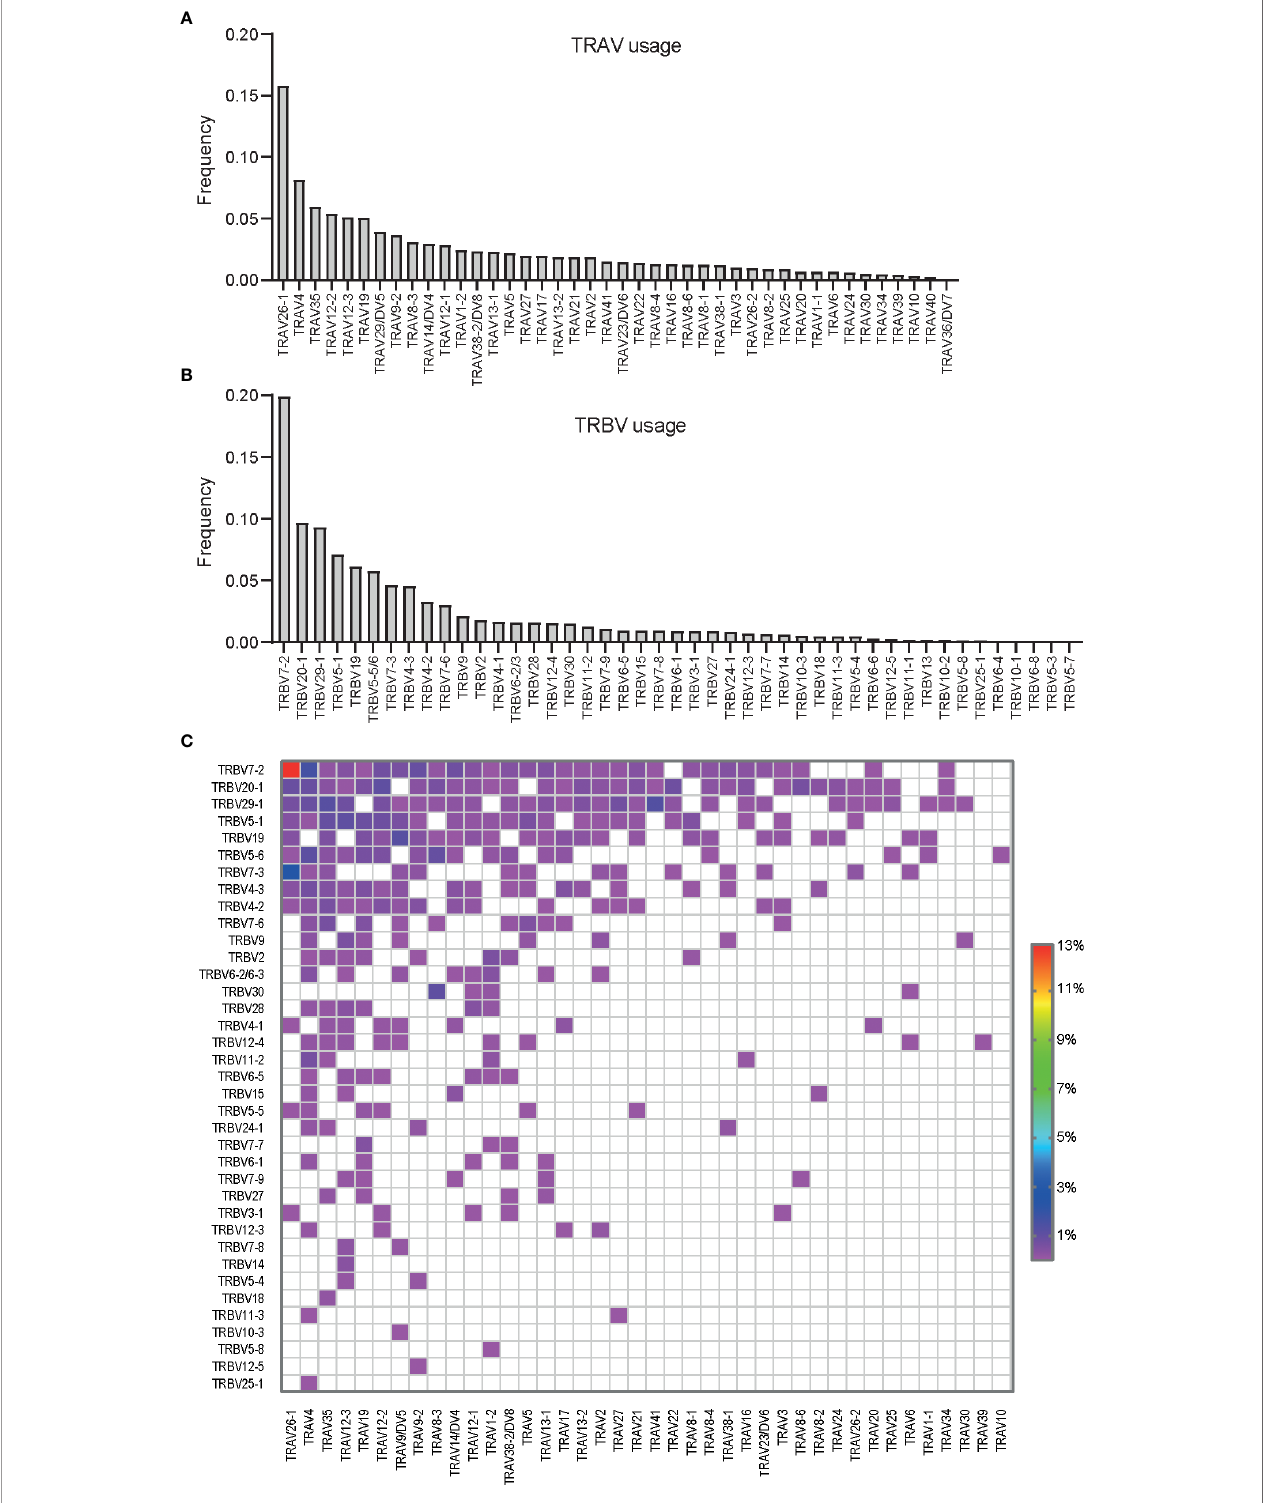
FIGURE 1 | The (A) TRAV, (B) TRBV and (C) paired TRAV : TRBV gene usage in T cells speci fi c to immunodominant gluten epitopes isolated using a cocktail of HLA-DQ2.5:gluten tetramers representing four immunodominant gluten epitopes (DQ2.5-glia- a 1a, DQ2.5-glia- a 2, DQ2.5-glia- w 1 and DQ2.5-glia- w 2). In total 2396 clonotypes from 30 CeD patients were analyzed where the V genes or V gene pair expressed in at least two clonotypes were